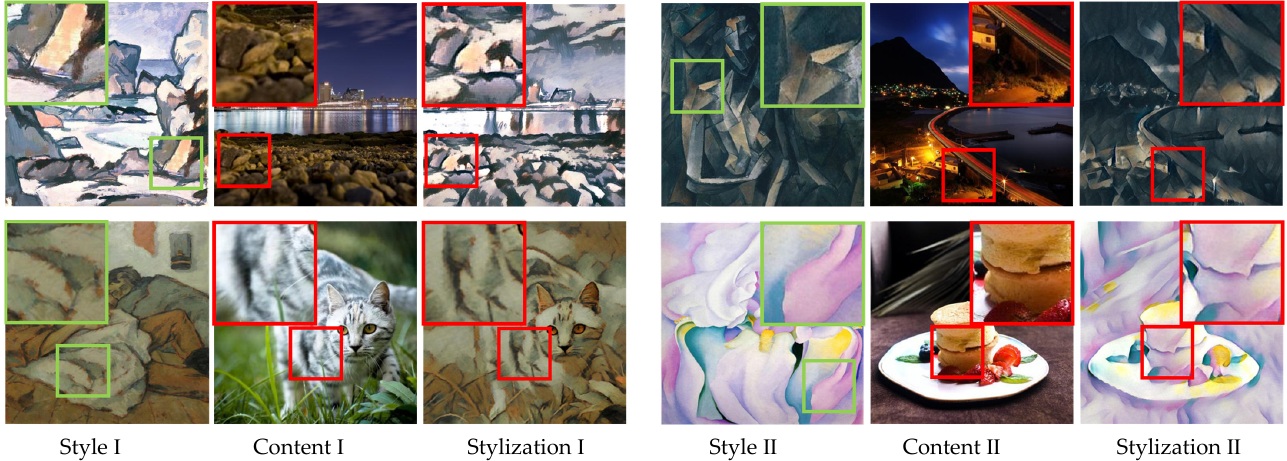
Figure 14. Comparison of local style details.